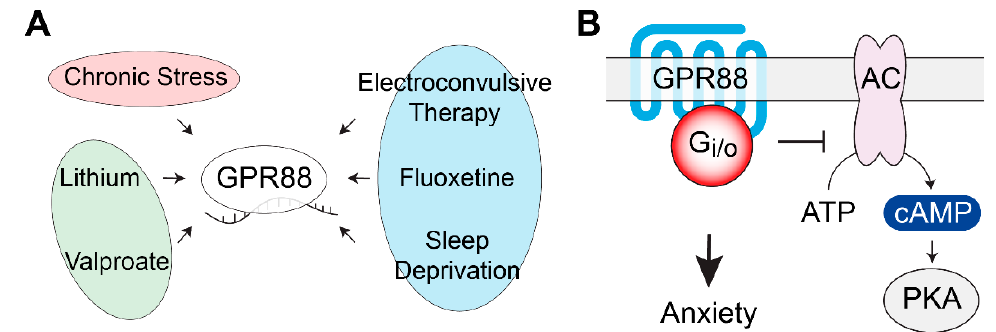
Figure 3. GPR88 gene expression regulation and signaling pathways. ( A ) GPR88 mRNA levels are modulated by antidepressant treatments, mood stabilizers, and by chronic stress in several brain regions. ( B ) Behavioral studies using conditional KO mice revealed the involvement of GPR88 expressed in the dopamine D2 receptor-expressing medium spiny neurons of the striatum in the development of anxiety-related phenotypes. AC, adenylate cyclase; PKA, protein kinase A.